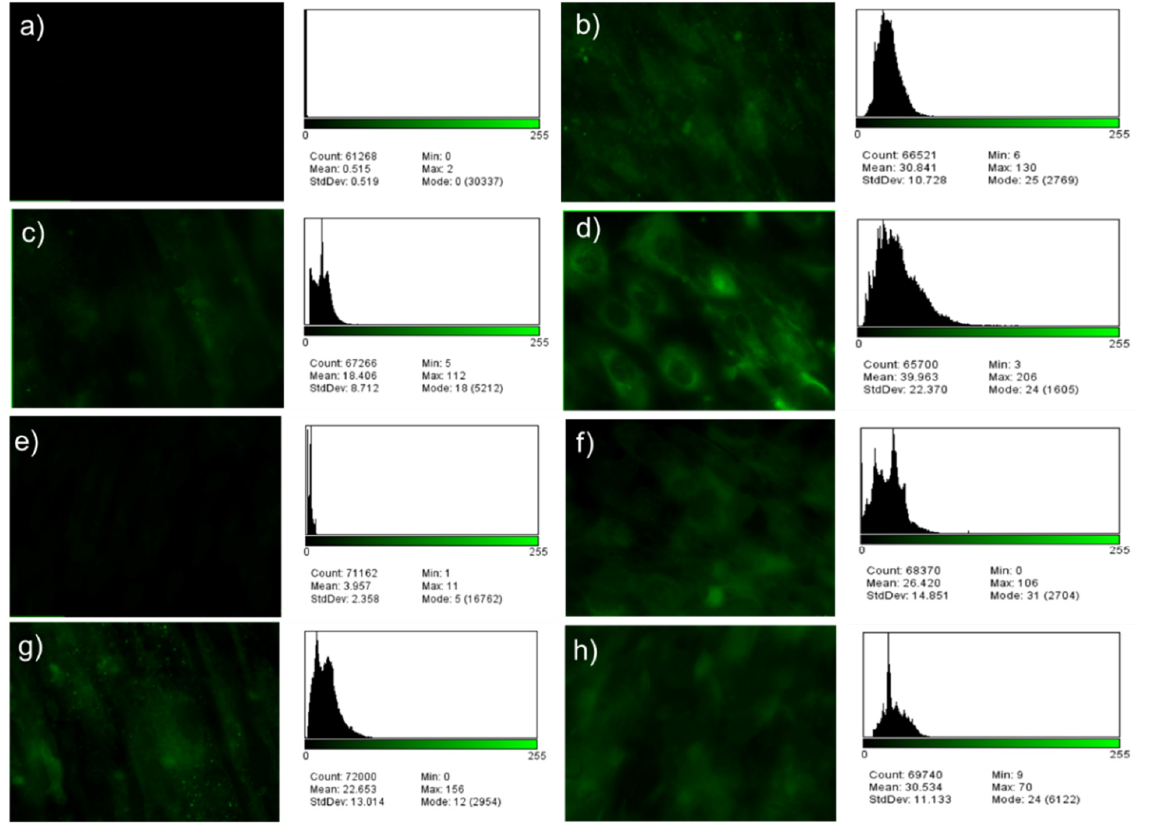
Figure 13. Fluorescence microscopic images and their analysis of histograms using the ImageJ software at 20 × , ( a – d ) are the hDPSCs and MG-63 cells cultivated on flat surfaces in conventional and differentiation media in relation to Figure 11; ( e – h ) are the hDPSCs and MG-63 cells cultivated on as-cast TNZT surfaces in conventional and differentiation media in relation to Figure 12.